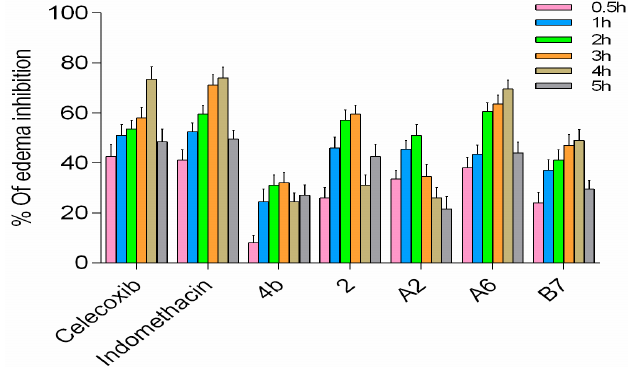
Figure 11. In vivo anti-inflammatory activity of A2 , A6 , and B7 against carrageenan-induced rat paw edema.